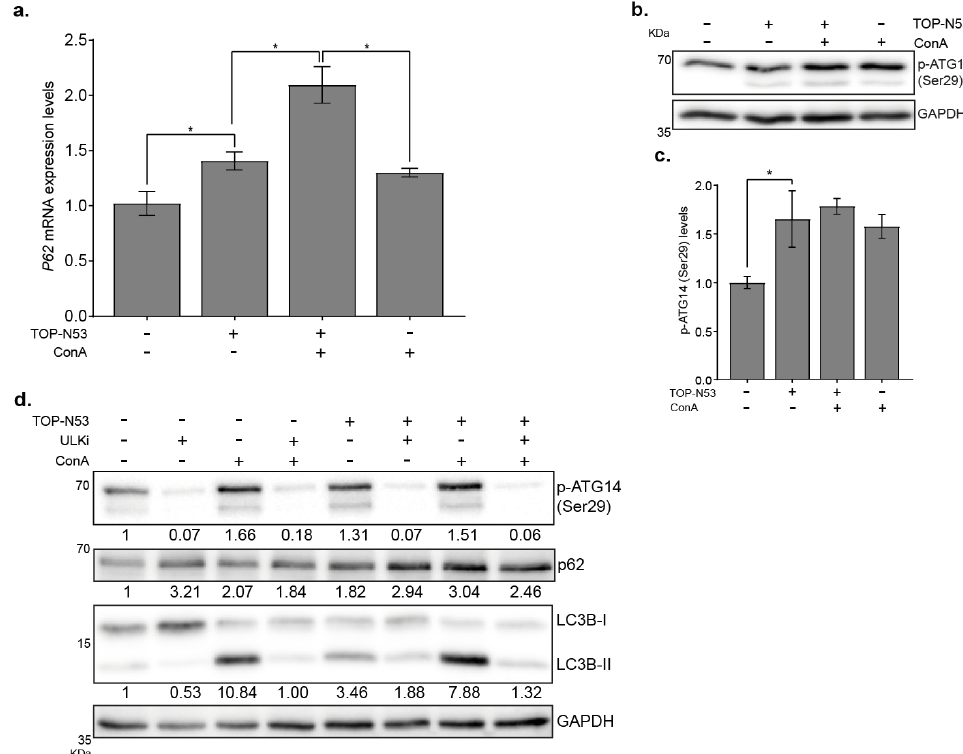
Figure 4. TOP-N53 activates canonical autophagy in NHFs. ( a ) P 62 mRNA levels in NHFs upon TOP-N53 treatment (1 μ M, 6 h) in presence or absence of ConA (2.5 nM, 2 h). Data were normalized to HPRT 1 levels and are represented as mean ± s.e. ( n = 3). * p ≤ 0.05 using one-way ANOVA with a Holm–Sidak test post-hoc analysis. ( b ) Analysis of ATG14 Ser29 phosphorylation in control and TOP-N53-treated (1 μ M; 24 h) NHF in presence or not of 2.5 nM ConA. Representative Western blot image and ( c ) quantification of p- ATG14 levels. Data were normalized to GAPDH and are represented as mean ± s.e. ( n = 3). * p ≤ 0.05 using one-way ANOVA with a Holm–Sidak test post-hoc analysis. ( d ) Analysis of the autophagic flux in NHFs upon treatment with TOP-N53 (1 μ M, 24 h) in presence or absence of ConA (2.5 nM, 2 h) and blockade of ULK1 with the specific inhibitor MRT68921 (1 μ M, 2 h). Representative Western blot ( n = 2) and its quantification below each protein panel (normalized to GAPDH).